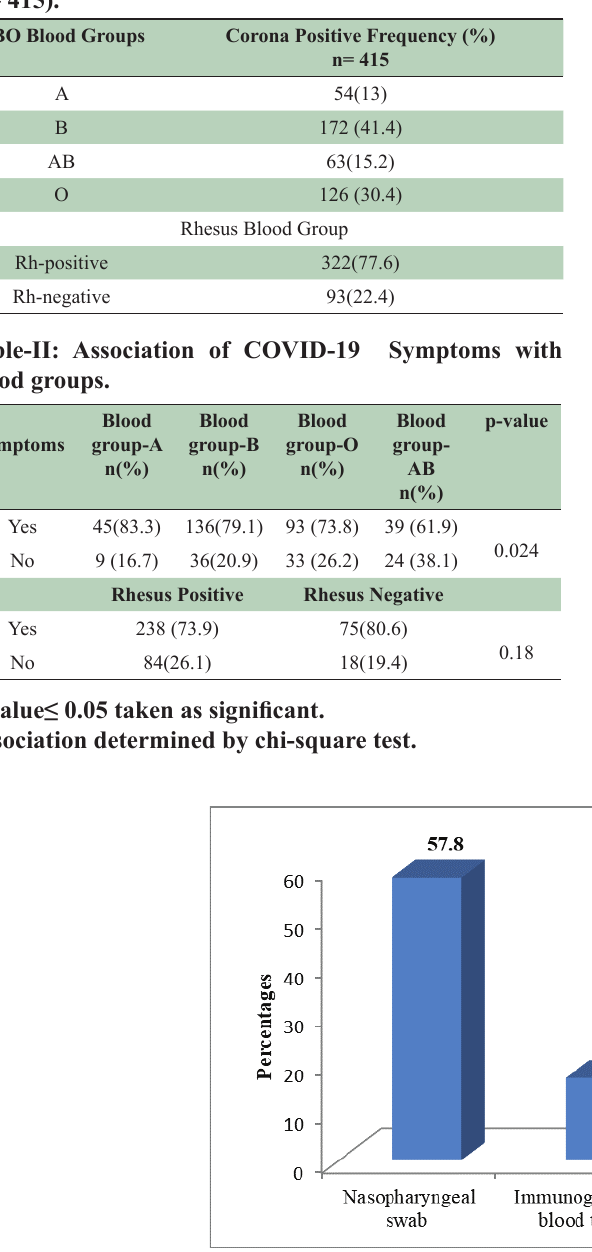
Figure-I: Confirmatory Tests Adopted By Subject For COVID-19 diagnosis